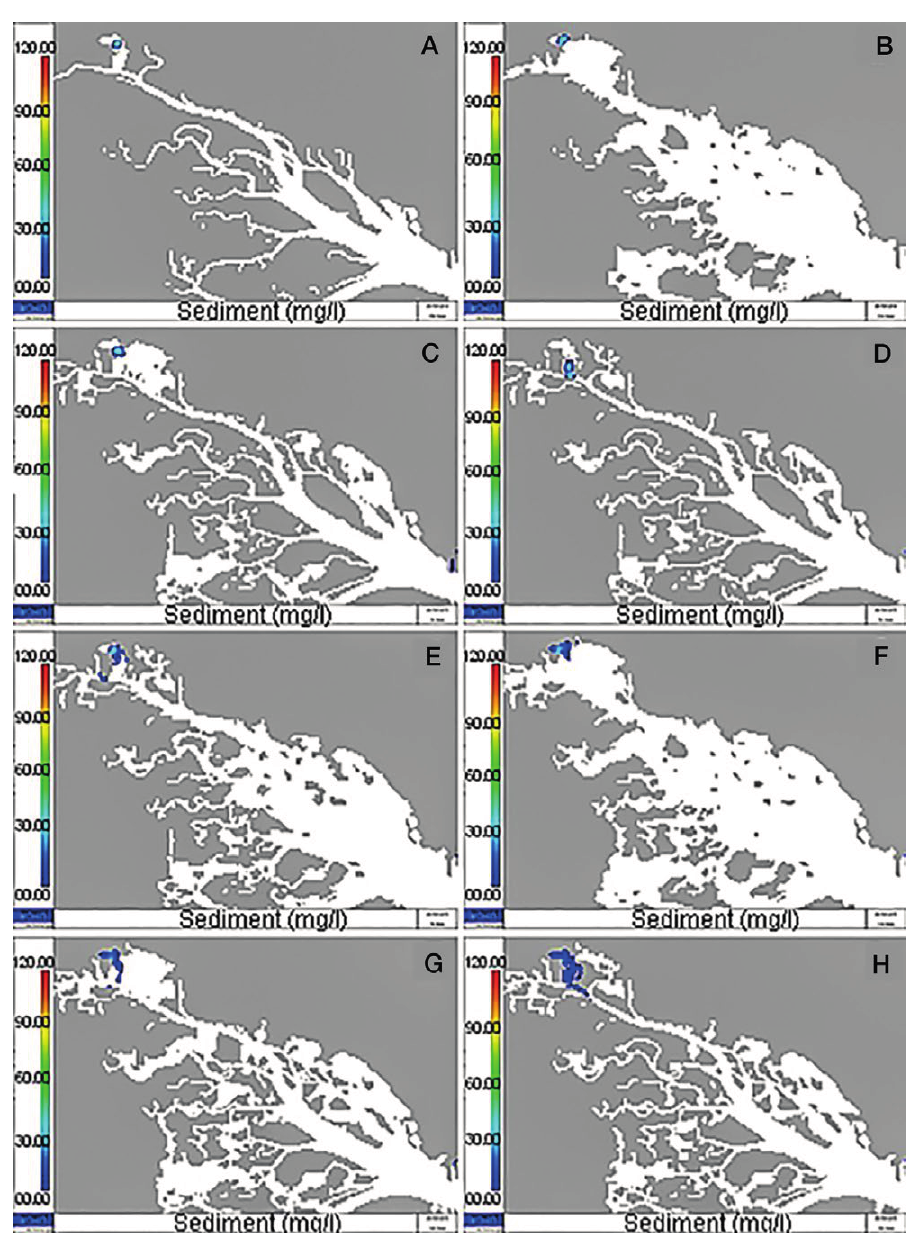
Fig. 11. – Biosediment suspended in the water column at Puerto Cuatreros. A, 15 hs; B, 21 hs on 14-12-2015; and C, 03 hs; D, 05 hs; E, 07 hs; F, 11 hs; G, 14 hs; H, 18 hs on